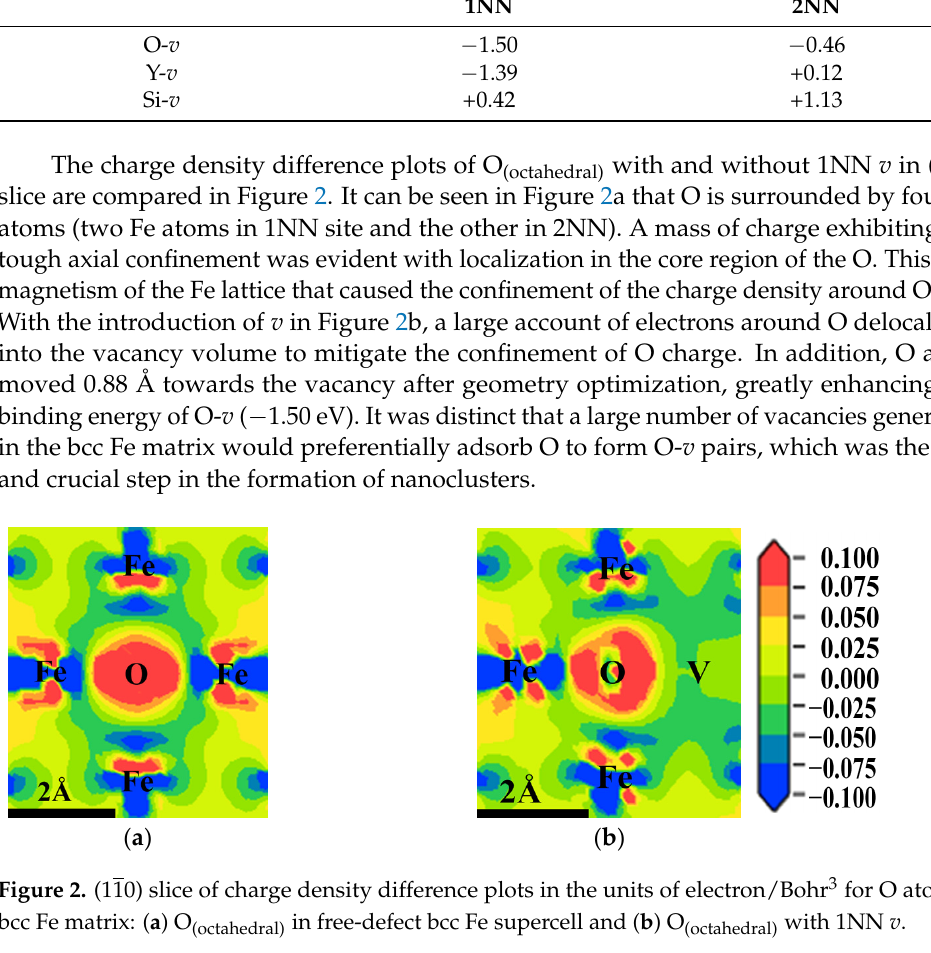
Table 4. The binding energies between the solutes (1NN and 2NN) and vacancies. Defect Species